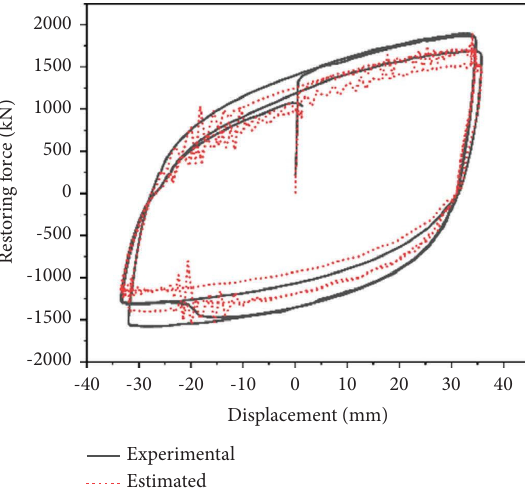
Figure 9: Hysteresis cycles for small range sampling parameters.